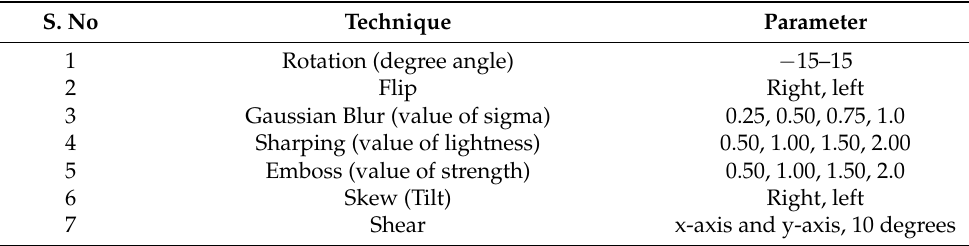
Table 1. The data augmentation with a range of